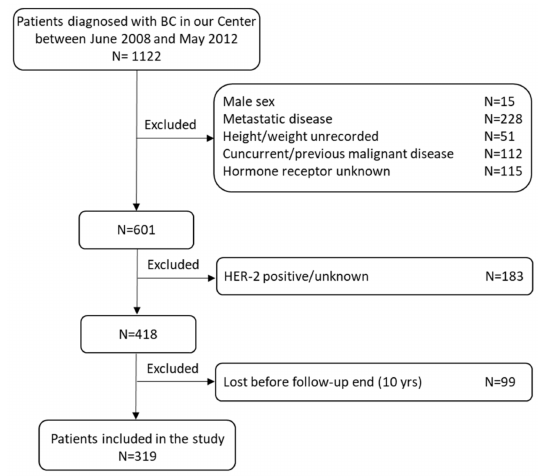
Figure 1. Study flow